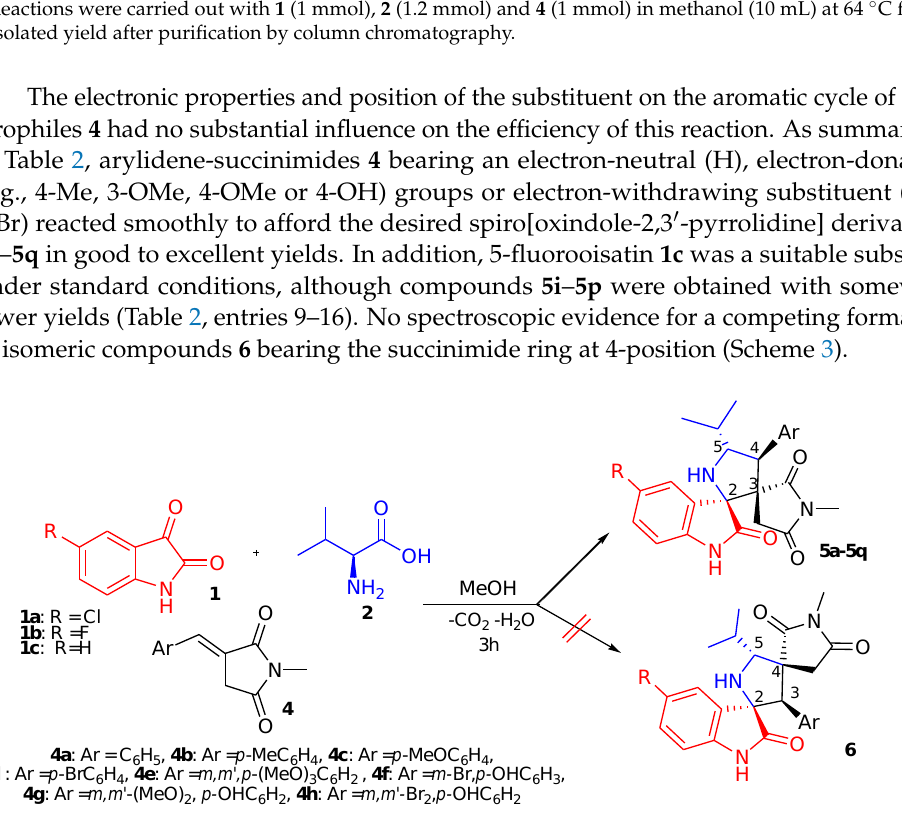
Scheme 3. 1,3-Dipolar cycloaddition route for the synthesis of spirooxindolepyrrolidines 5 Table 2. Synthesis of the spirooxindole pyrrolidines 5 a .